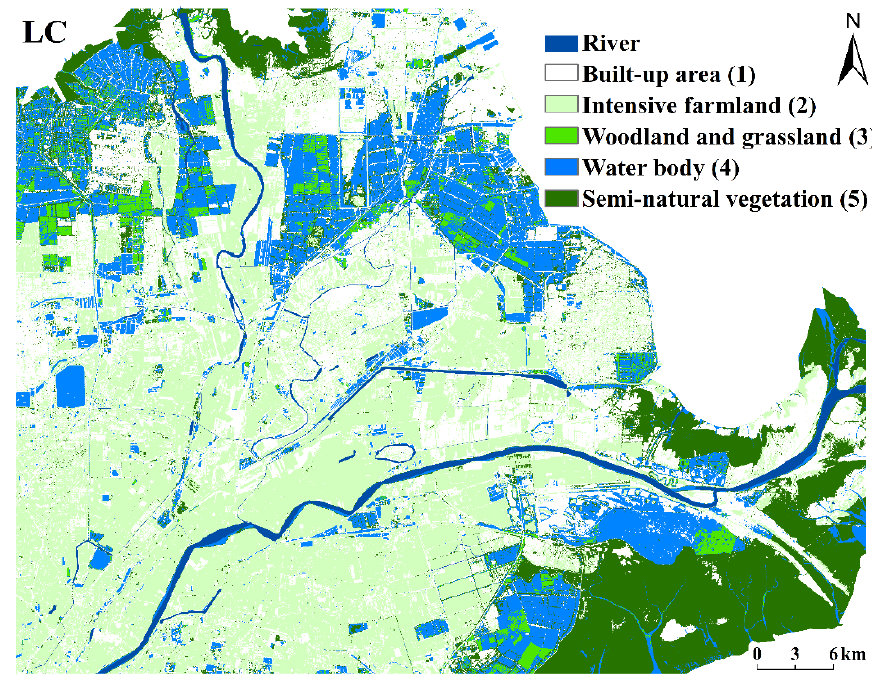
Figure 2. The land cover map in the study area.